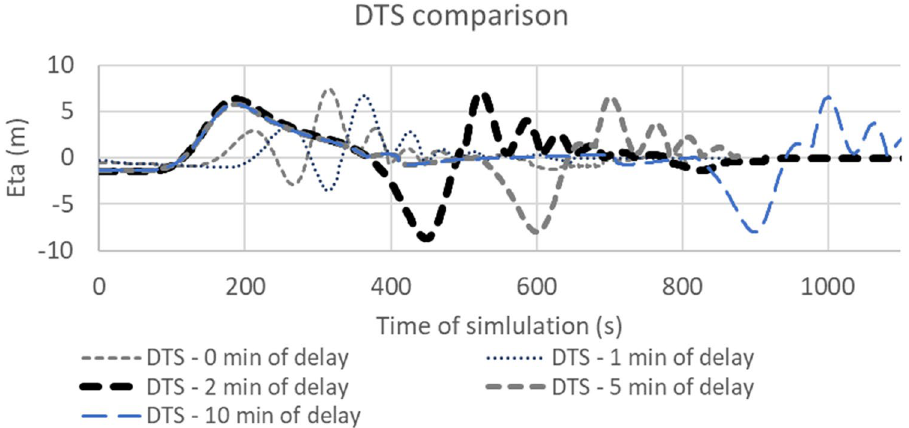
Figure 11. Comparison of sea-surface elevation (Eta) for DTS scenarios modelled on Catania area with different time delays between fault displacement and landslide